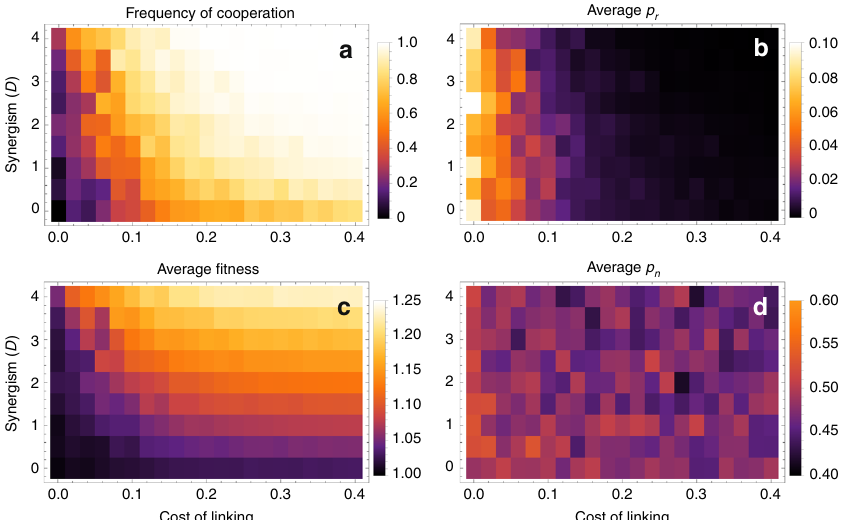
Fig. 5 Effect of synergistic payoffs on cooperation ( a ) and the probabilities of random linking p r ( b ), and social inheritance p n ( d ), and the mean fi tness ( c ). Simulations and averages were performed as in Fig. 4. Here, B = 1; the other parameters as in Fig. 4